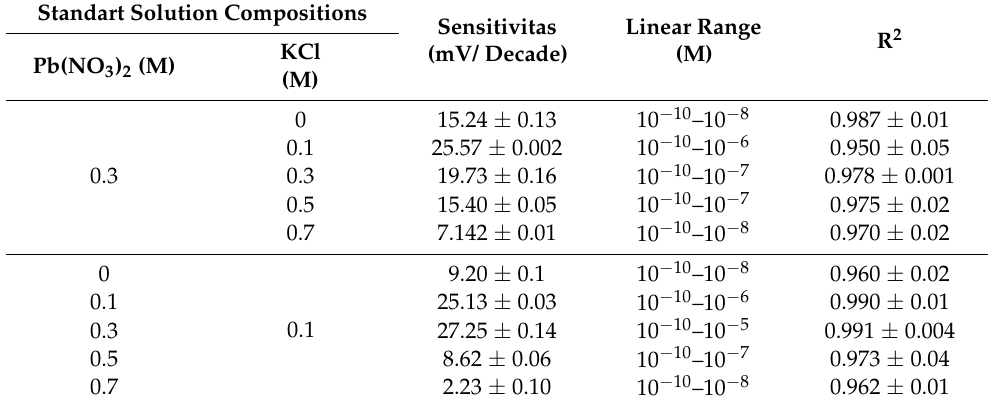
Table 2. Sensitivity of the electrode depending on the internal standard component variation. Standart Solution Compositions Sensitivitas Figure 4. Profile of Pb 2+ ISE sensitivities and linear ranges on the variation of internal solution Pb(NO 3 ) 2 ( a ) and KCl ( b ).